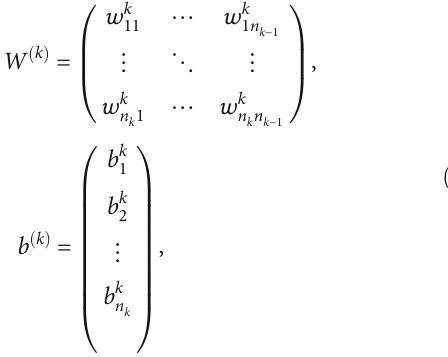
Figure 8: Exact dynamics and learned dynamics of u ð x , t Þ . Table 1: mkdv equation: L 2 -norm error between the predicted and exact solutions of u ð t , x Þ for di ff erent numbers of hidden layers and di ff erent numbers of neurons per layer. The number of training points is N u = 100 , and collocation points is N f = 20000 .